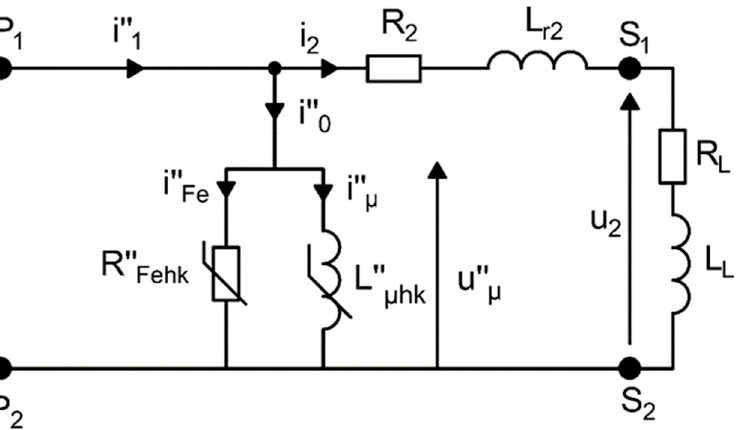
Figure 1. Equivalent circuit of inductive current transformer for distorted current transformation.